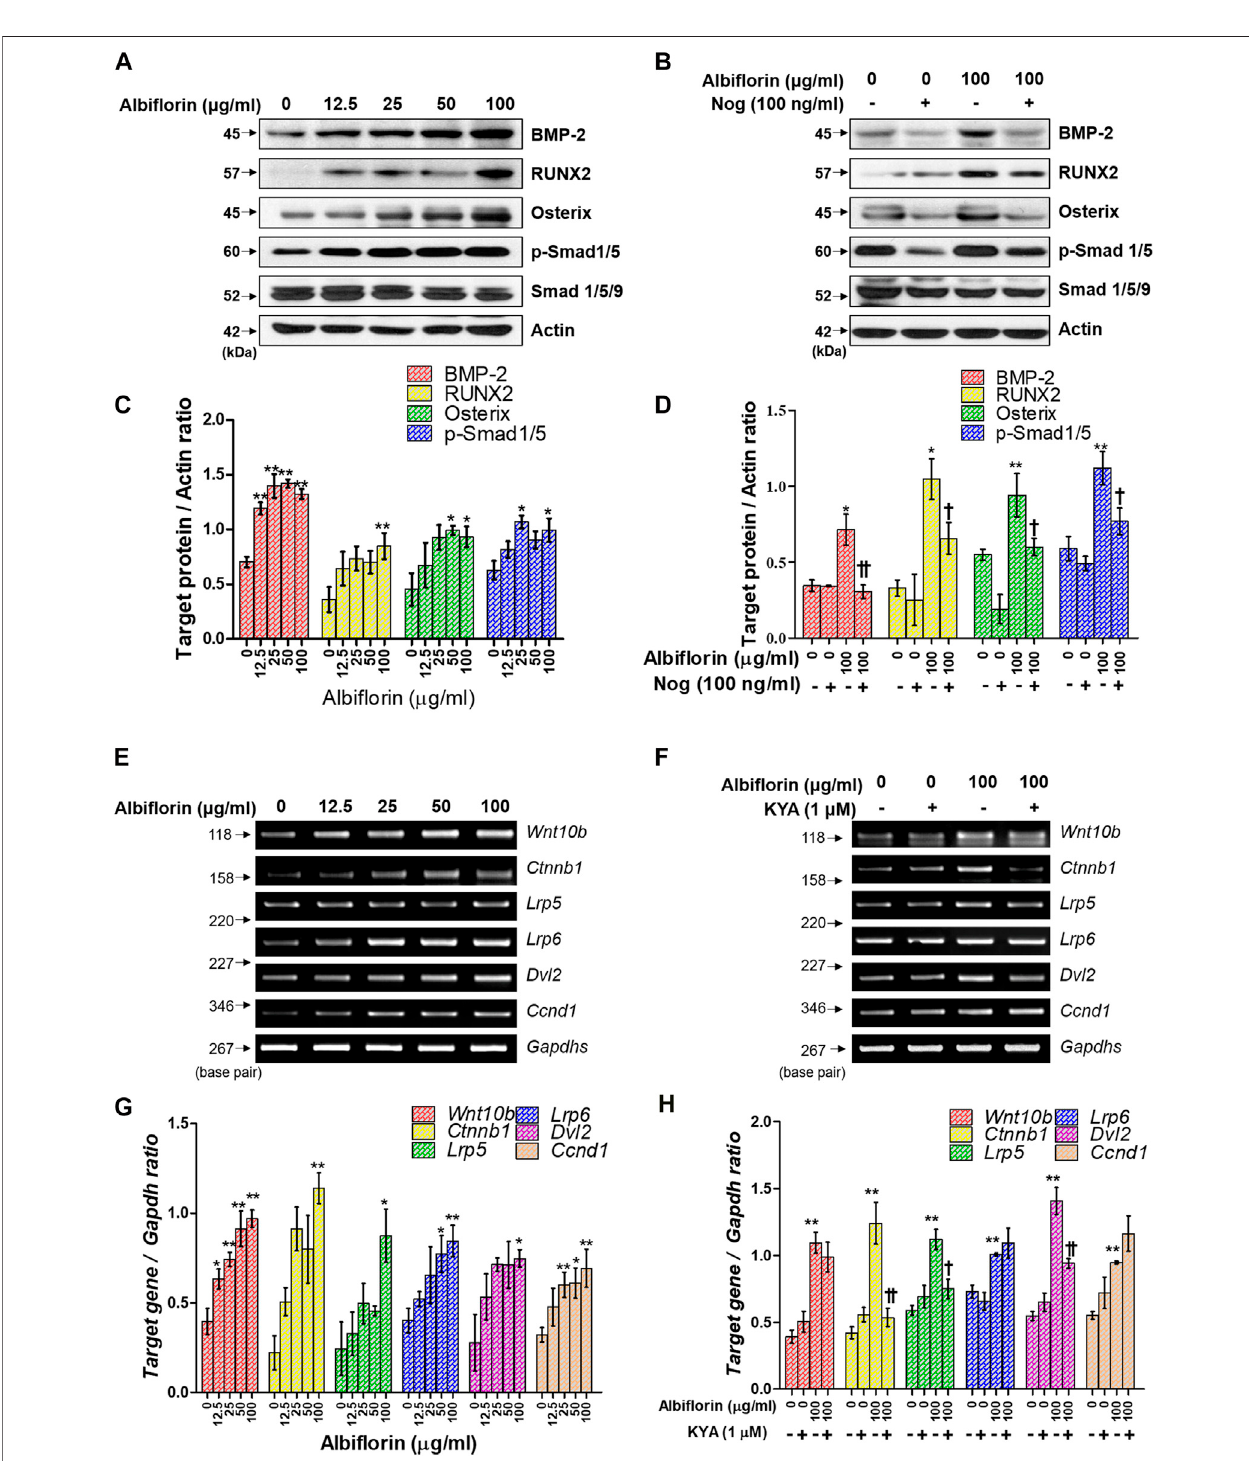
FIGURE 6 | Effect of albi fl orin on BMP-2/Smad and Wnt/ β -catenin signaling (A, B) The effect of albi fl orin on BMP-2 signaling-related protein expression was analyzed with or without the BMP-2 inhibitor noggin using western blot assay. (C, D) BMP-2, RUNX2 and osterix were quanti fi ed through actin, and p-Smad1/5 was normalizedthroughSmad1/5/9 (E,F) Theeffect ofalbi fl orin onWntcanonicalpathway-relatedmRNAexpression wasmeasuredwithorwithoutWnt/ β -catenin inhibitor KYA1797KusingRT-PCRassay. (G,H) TheexpressionofallmRNAwasquanti fi edwithrespecttothatof Gapdhs .Theseresultsarepresentedasthemean ± SEM (n (cid:2) 3 for each experimental). ** p < 0.01, * p < 0.05 vs. osteogenic medium cells. †† p < 0.01, † p < 0.05 vs. 100 μ g/ml albi fl orin-treated cells.